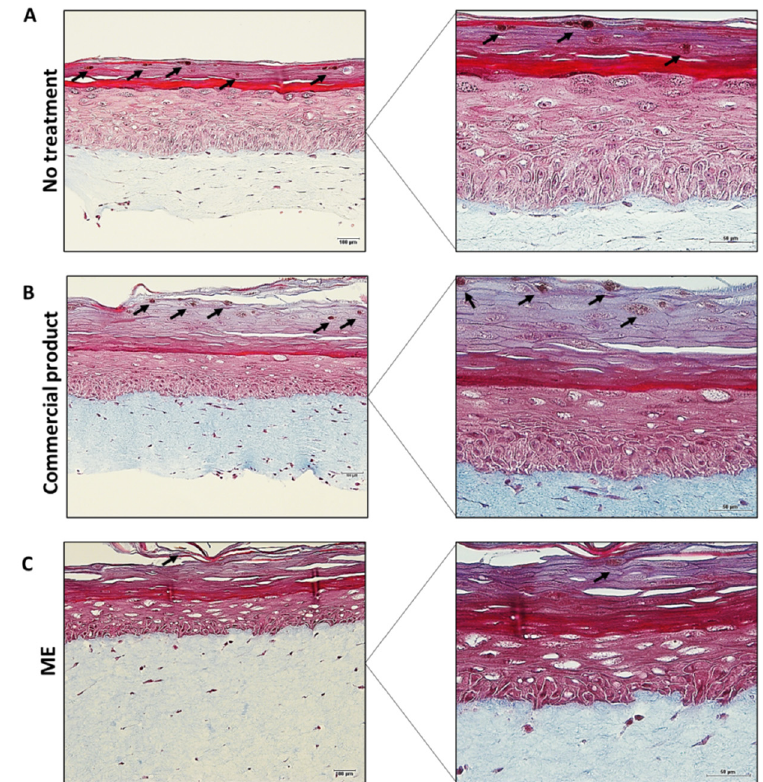
Figure 10. Histology of pigmented reconstructed human skin stained for Fontana Masson. ( A ) untreated skin; ( B ) skin treated with the commercial product; ( C ) skin treated with ME containing the extract. Left panel: Bar = 100 μ m, original magnification 20x. Right panel: Bar = 50 μ m, original magnification 40x. Arrows indicate the melanin spots. Data are representative of the three independent experiments.